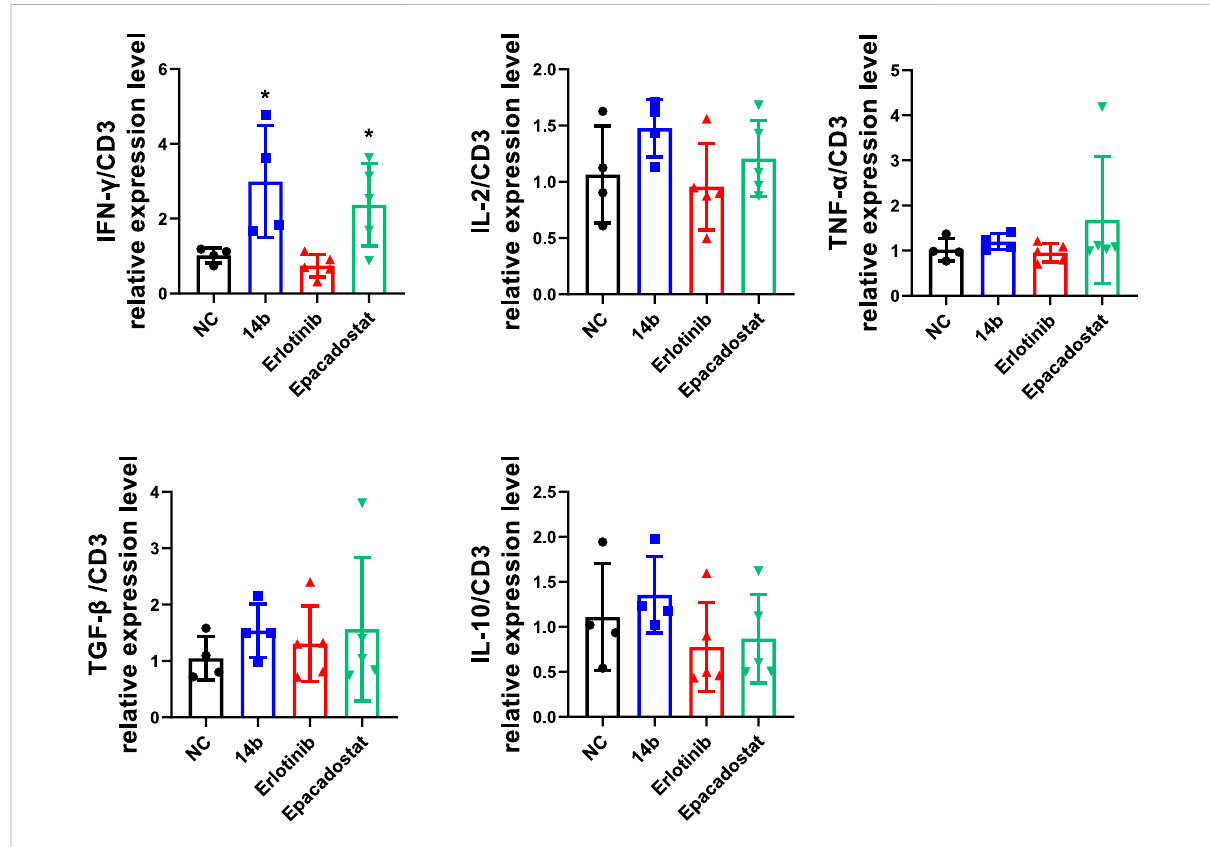
FIGURE 9 Compound 14b regulates T cell function-associated genes in TME. Cytokines associated with T cell functions including IFN- γ , IL-2, TNF- α , TGF- β and IL-10 within 4T1 tumors were analyzed by qPCR.